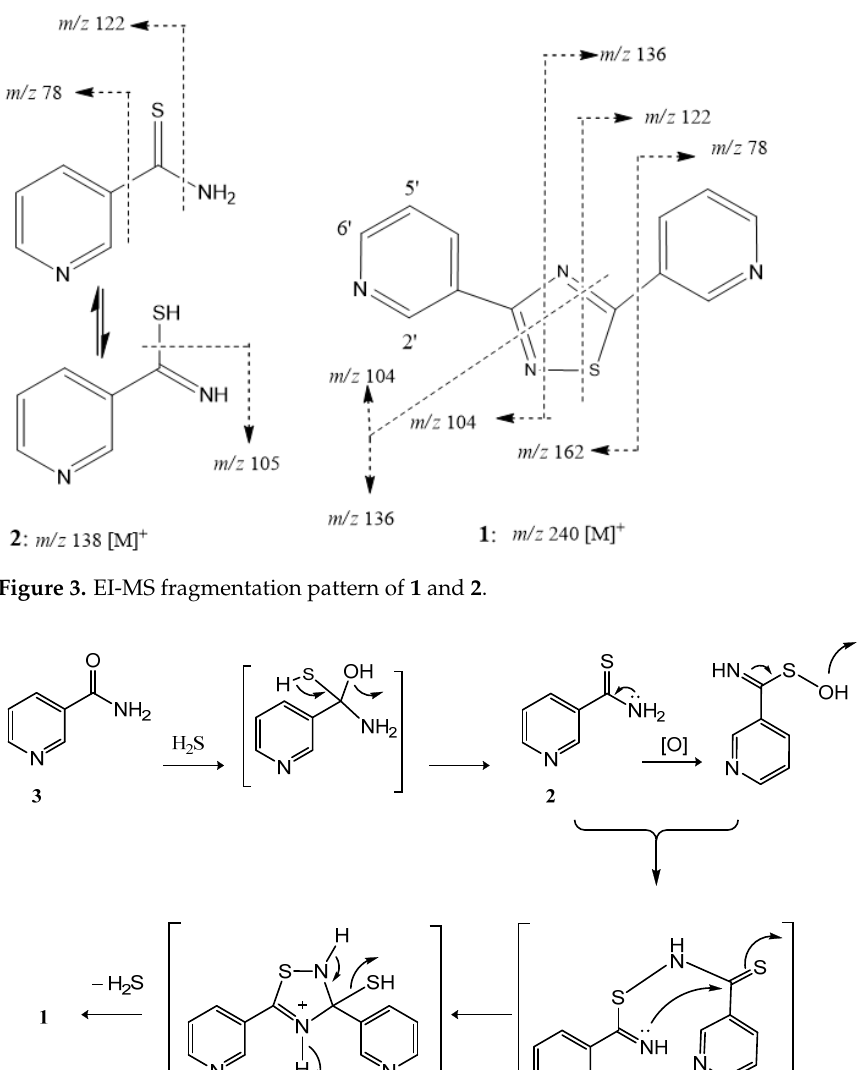
1 H- 1 H COSY and HMBC correlations of 1 and 2 . Figure 2. 1 H ‐ 1 H COSY and HMBC correlations of 1 and 2. Figure 2.